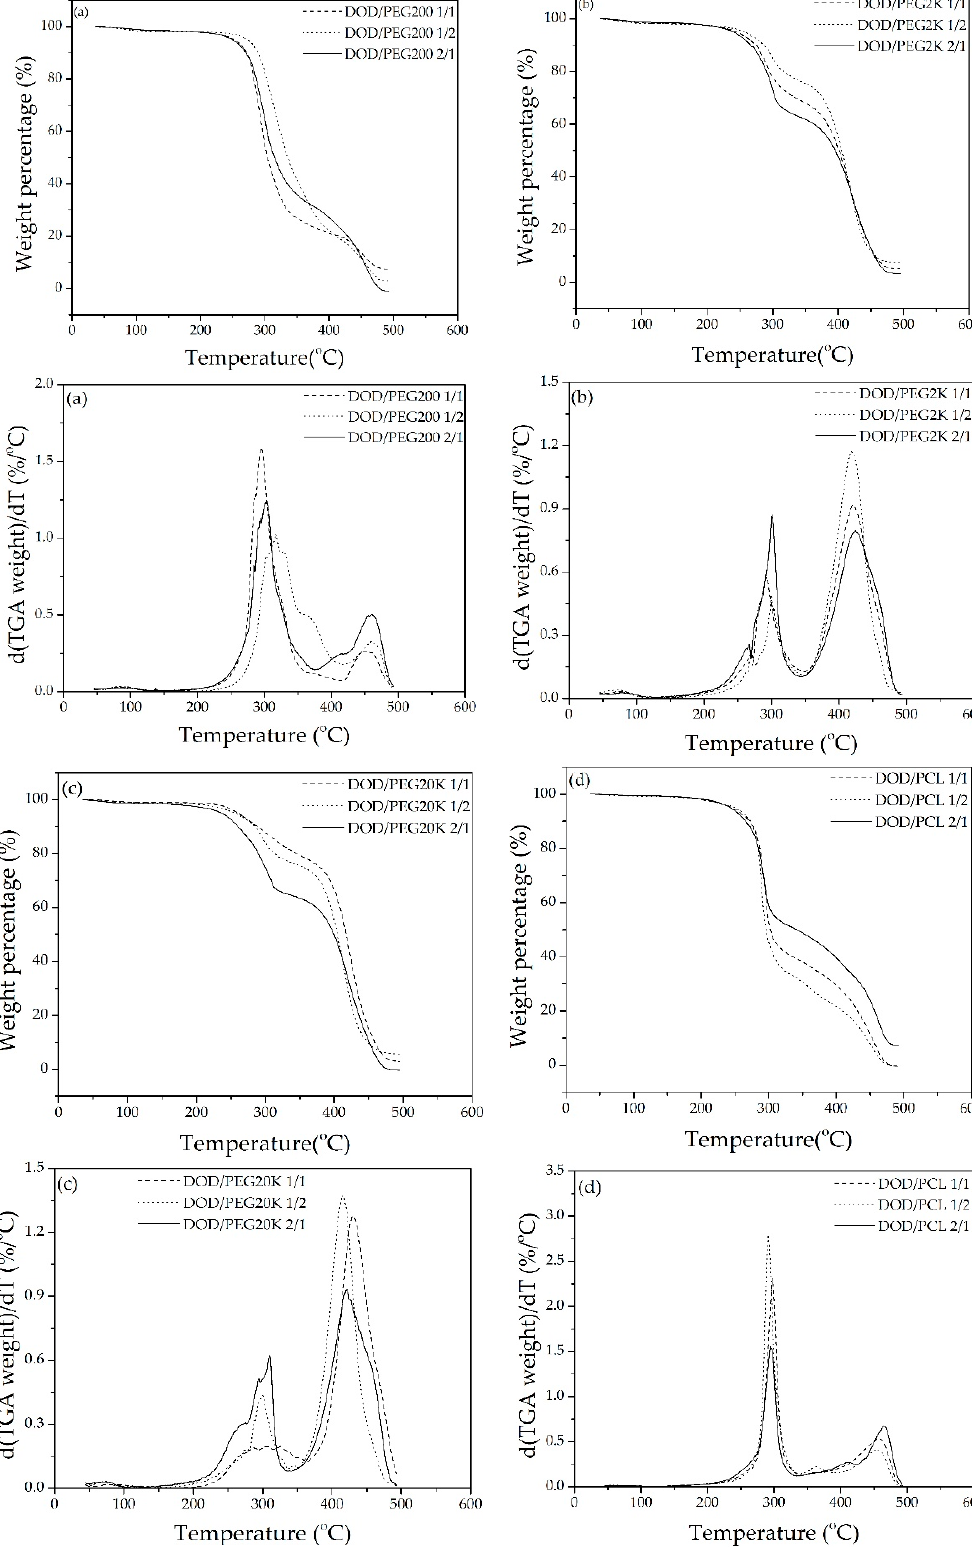
Figure 9. TGA curves and their derivative curves of ( a ) PU-DOD/PEG200, ( b ) PU-DOD/PEG2K, ( c ) PU-DOD/PEG20K, and ( d ) PU-DOD/PCLDO.